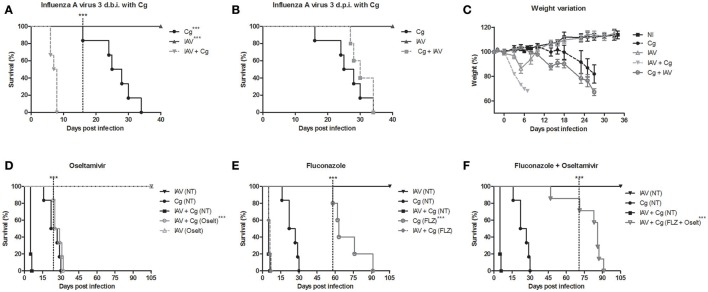
Survival curve (A,B), weight variation (C) and treatment with antiviral oseltamivir (D), antifungal fluconazole (E), and combined treatment (F) of C. gattii co-infection with Influenza A virus H1N1 (PR8). Six mice per group were infected i.t. with 1 × 104 CFU of C. gattii, or a sublethal dose of Influenza A virus i.n. (1 × 103 PFU/animal) or both. Cg: C. gattii; IAV: Influenza A virus; IAV+Cg: Influenza A virus 3 days before infection (3 d.b.i.) to C. gattii; Cg+IAV: Influenza A virus 3 days post-infection (3 d.p.i.) to C. gattii. NI: group not infected; NT, Non-treated group; FLZ, Fluconazole; Oselt, Oseltamivir. - - - -The dotted vertical line indicates when the statistically difference between the groups began. ***p < 0.0005. Data are representative of three independent experiments.